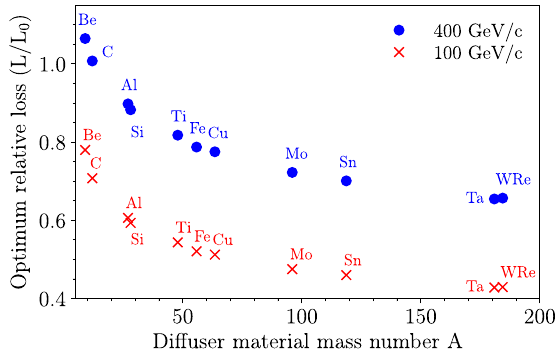
FIG. 4. Analytical calculation of the optimum relative total loss with a diffuser as a function of diffuser atomic number A, for 100 and 400 GeV =c protons.